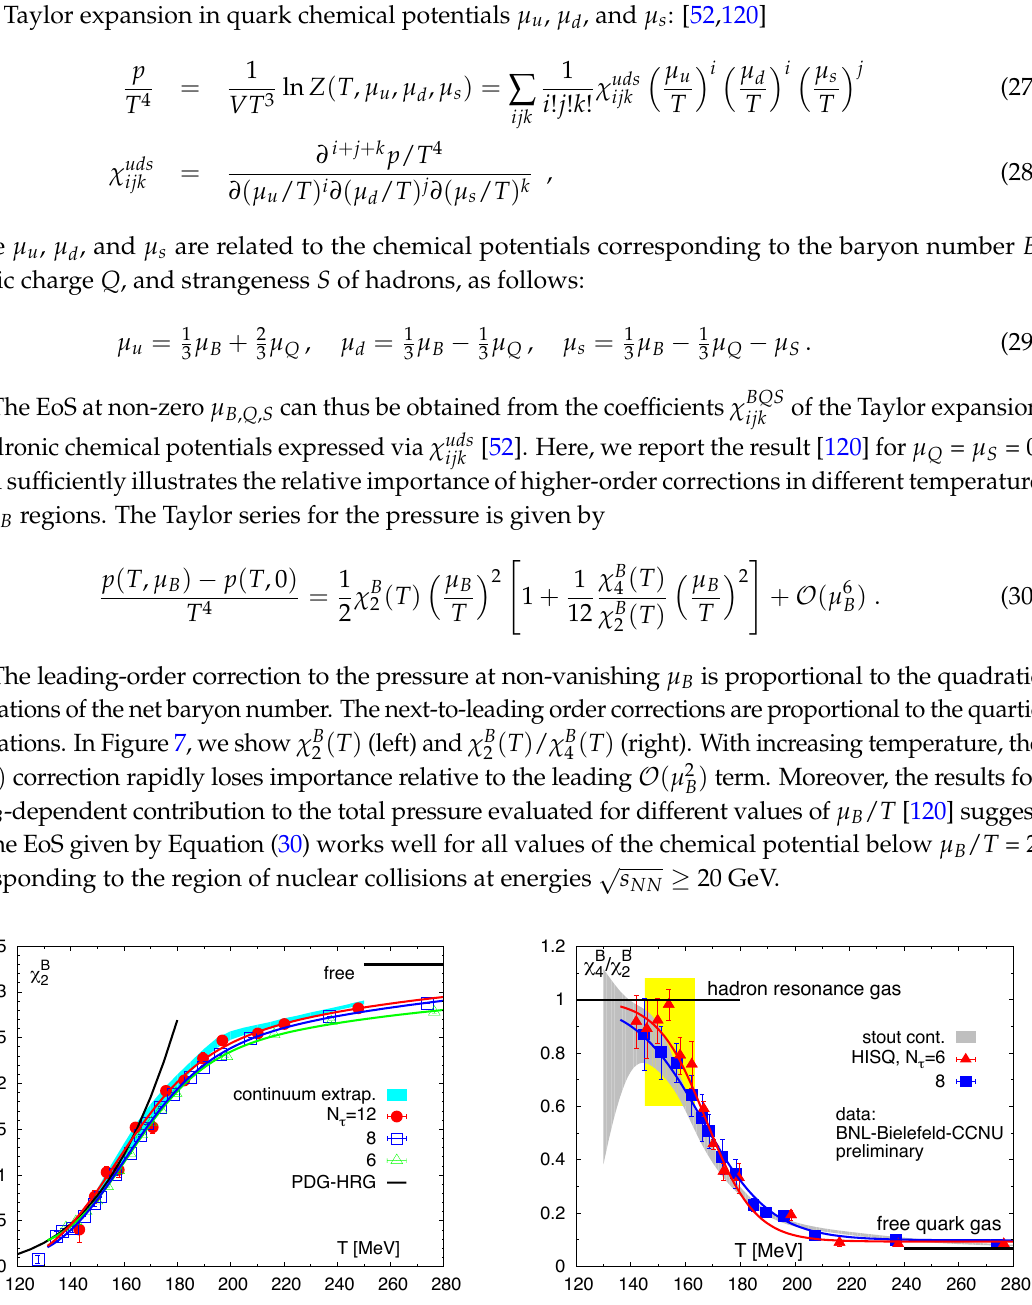
Figure 7. The expansion coefficients of the pressure at the non-zero baryon chemical potential adopted from Ref. [120]. Left : The leading-order correction; Right : The relative contribution of the next-to-leading order lcorrection. BNL: Brookhaven National